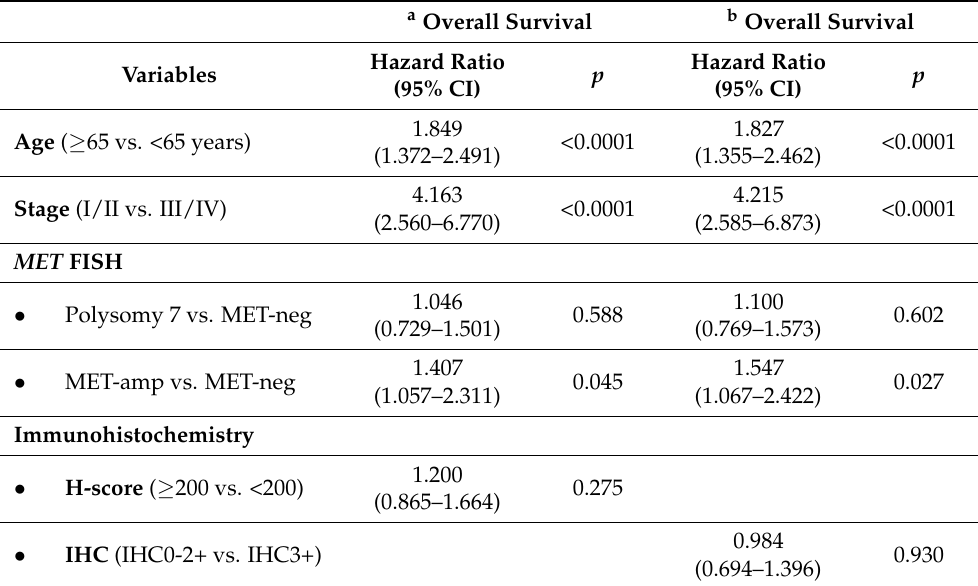
Table 4. Multivariate cox proportional hazard regression analysis for overall